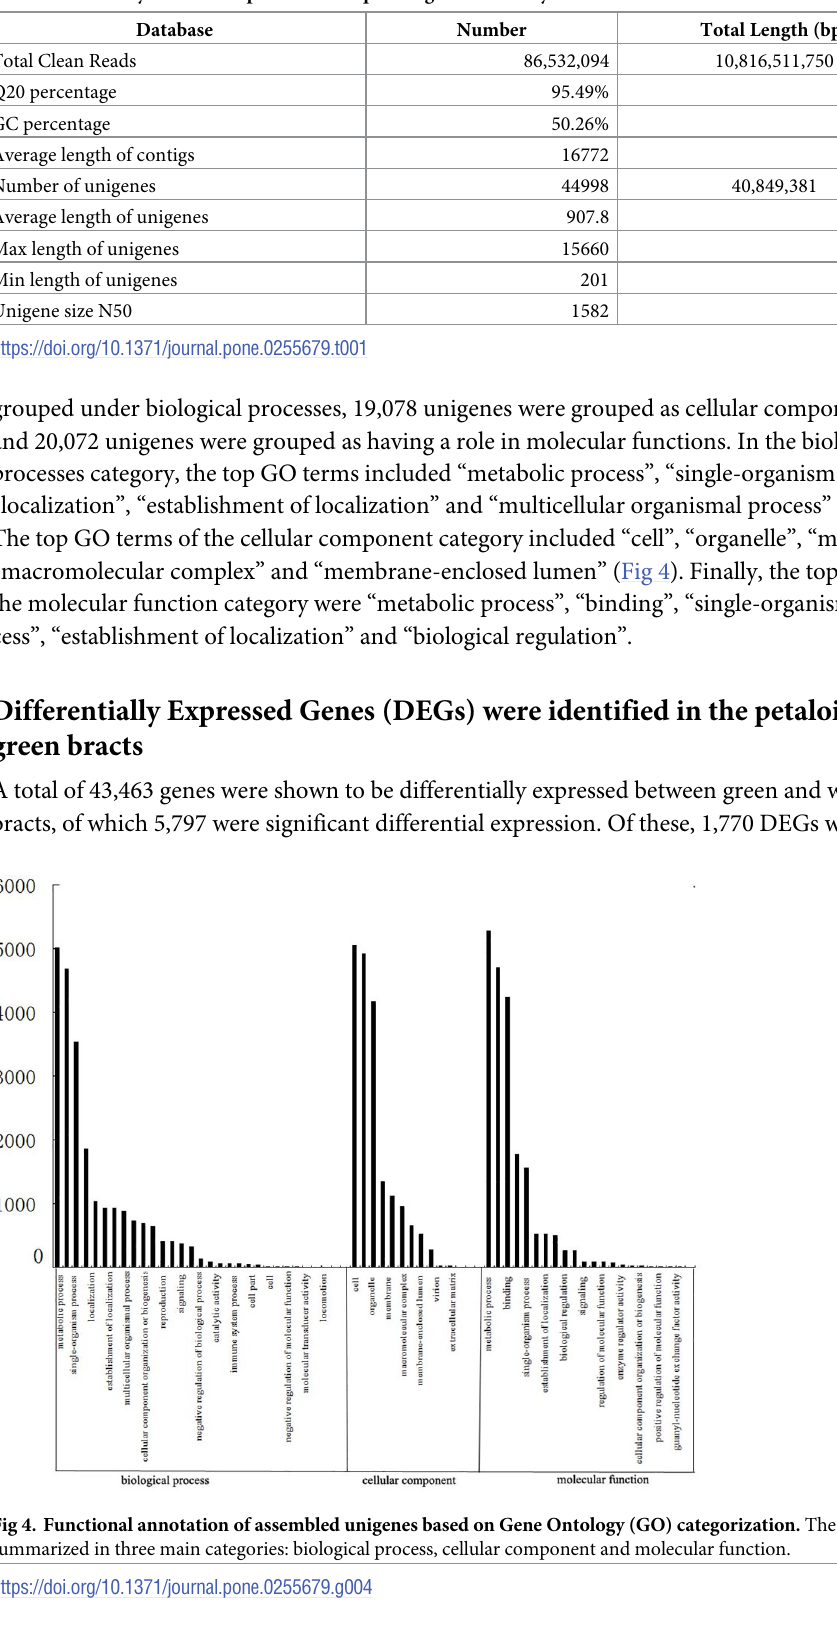
Table 1. Summary of illumina paired-end sequencing and assembly for S . chinensis .